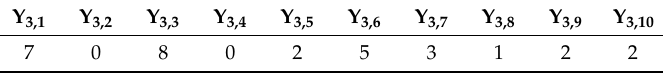
Table 4. Available capacity for UDC 3 .